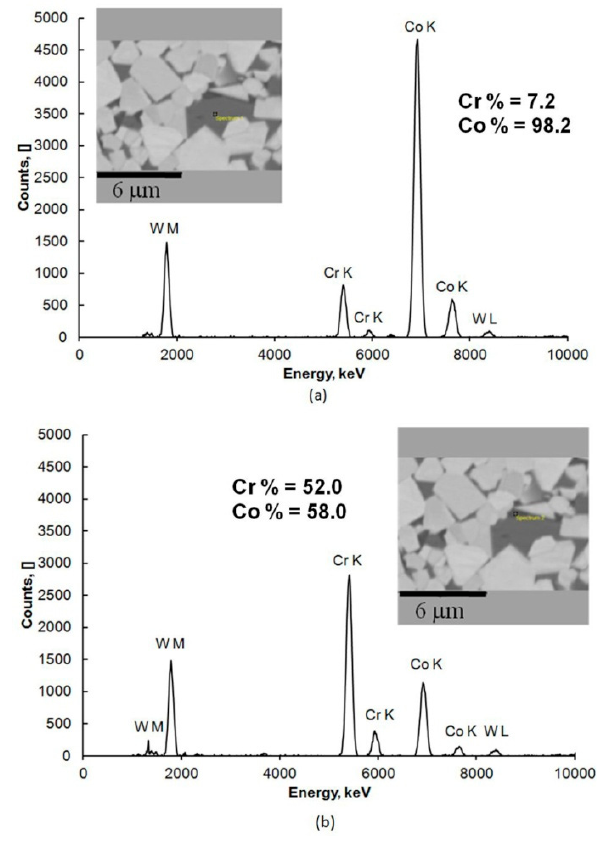
Figure 3. SEM microstructure and EDX analysis: ( a ) the binder phase and ( b ) the M 7 C 3 carbide observed at 3 wt% addition of Cr 3 C 2 (concentrations are in at%).